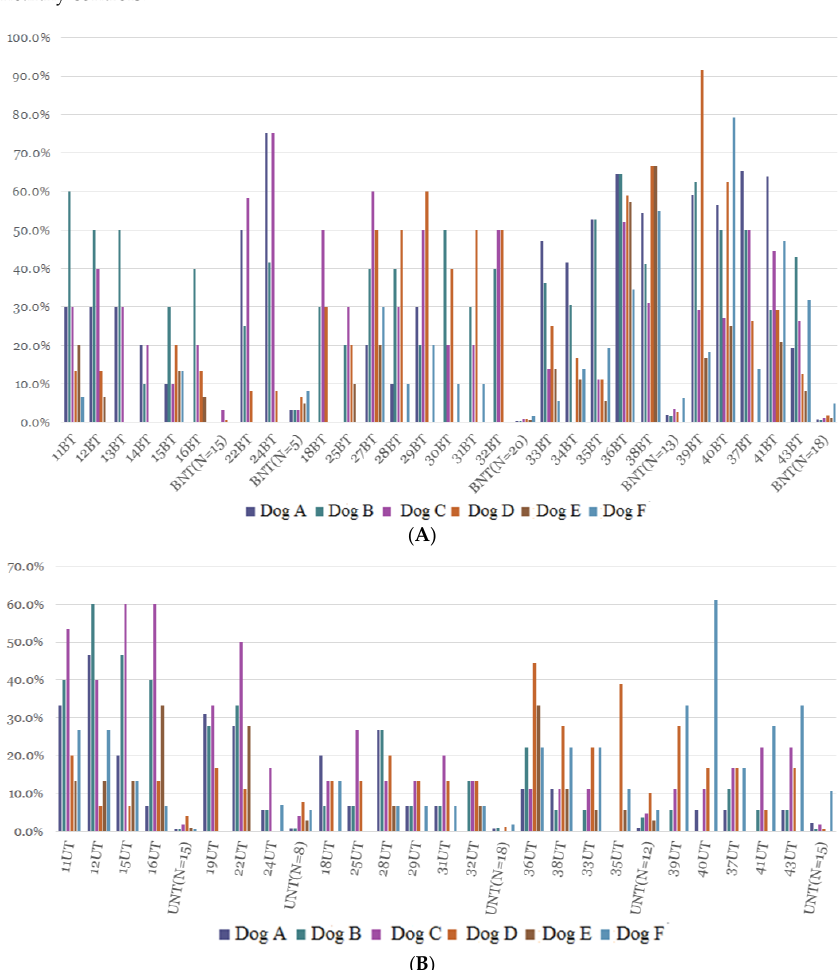
Figure 2. ( A ) Individual canine response rates after using lung cancer tissue samples training. Individual canine response rates to exhaled breath collected from patients with a confirmed diagnosis of lung cancer, from patients with confirmed diagnosis of non-lung cancer, and from healthy controls after using lung cancer tissue samples training. ( B ) Individual canine response rates after using lung cancer tissue samples training. Individual canine response rates to urine samples collected from patients with a confirmed diagnosis of lung cancer, from patients with confirmed diagnosis of non-lung cancer, and from healthy controls after using lung cancer tissue samples training.